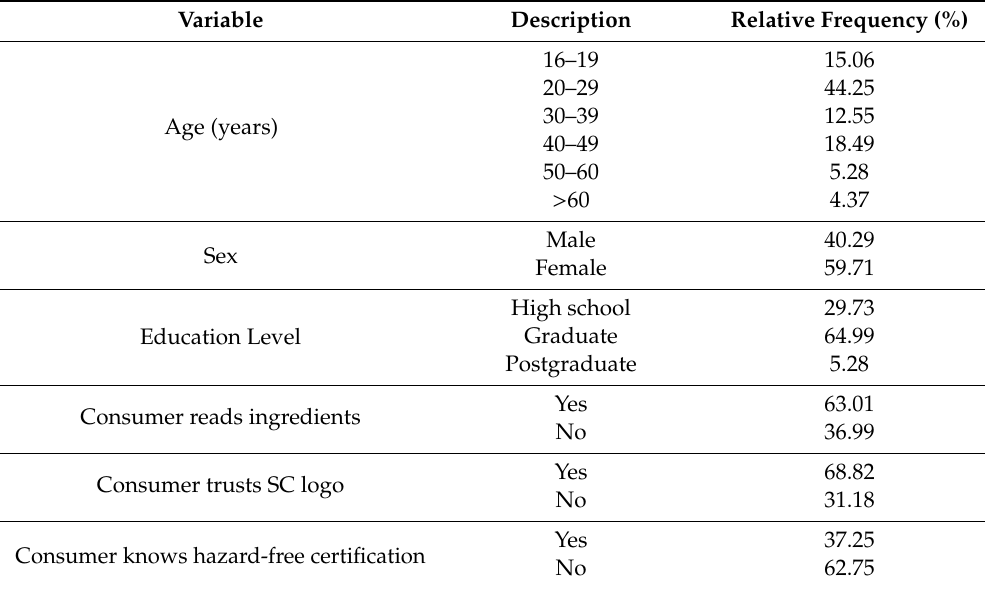
Table 2. Descriptive statistics of the